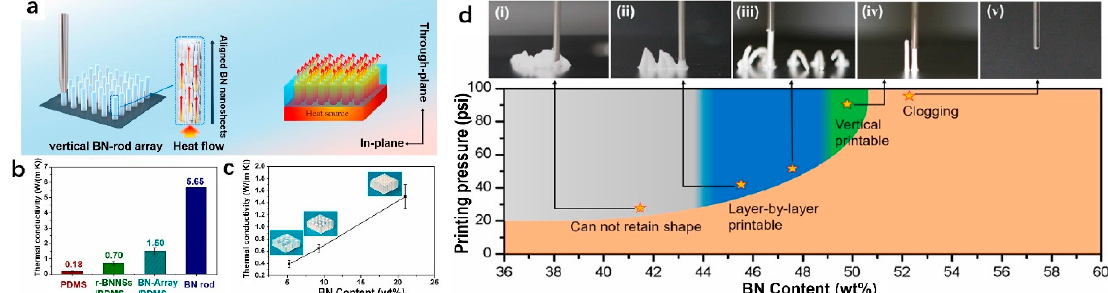
Figure 6. ( a ) The left image is a schematic illustration of the fabrication of BN arrays using DIW, the middle inset is a magnified aligned BN nanosheet, and the right image is a schematic illustration of thermal conduction along the vertically aligned BN sheets; ( b ) through-plane thermal conductivity of pure PDMS, random BN/PDMS, BN arrays/PDMS, and BN rods; ( c ) through-plane thermal conductivity of different numbers of BN rods/PDMS; ( d ) printability of extruded ink filaments at different BN contents, insets ( i – v ) showing the shape retention ability of vertical printing (reproduced with permission from Reference [38], Copyright 2019 American Chemical Society).